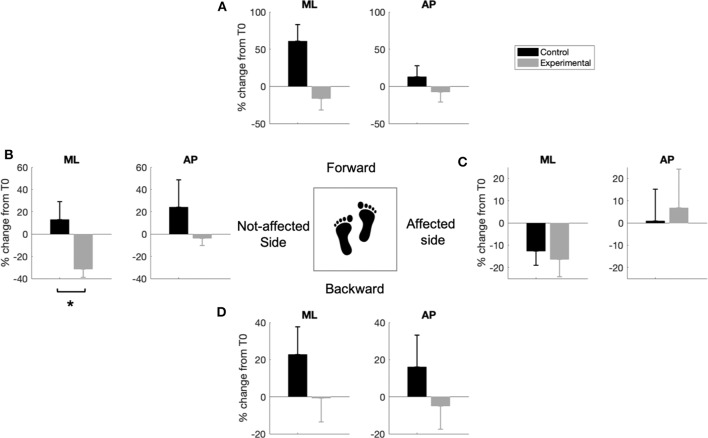
Rate of improvement T0-T1 for the reactive balance test. Each bar plot represents the percentage change of the mediolateral (ML) or anteroposterior (AP) trunk oscillatory range when the platform is inclined in the forward (A), backward (D), affected (C), and non-affected (B) side of the body, for the control (black) and experimental (gray) groups. Error-bars indicate standard error, * highlight a significant difference between groups p < 0.05.